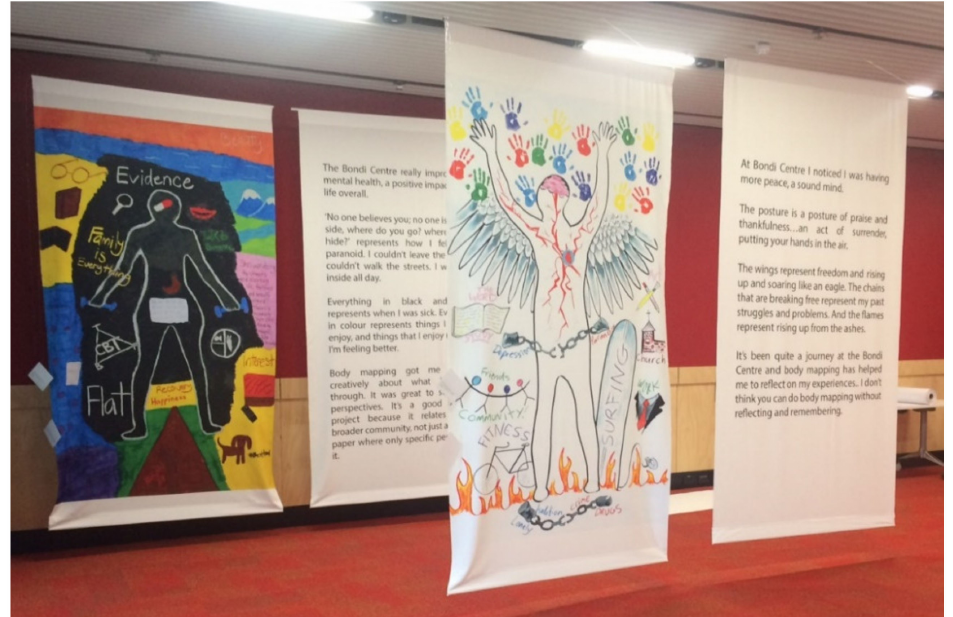
Figure 2. Body maps on display at Keeping the Body in Mind , an exhibition co-presented by the Black Dog Mental Health Institute and the National Institute of Dramatic Arts in 2016. Photograph by Katherine M.